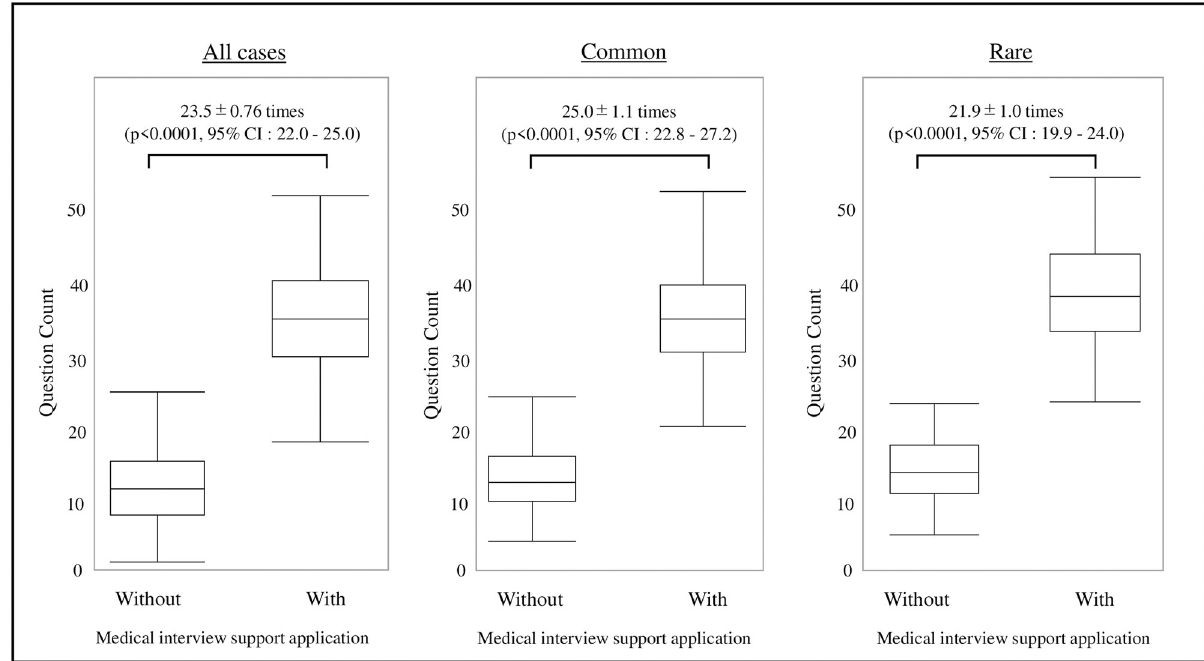
Fig 4. Number of questions per medical interview. A box-and-whisker diagram is shown for the number of interviews in the groups with and without the medical interview support application. In all validations, the number of interviews significantly increased in the group that used the medical interview support